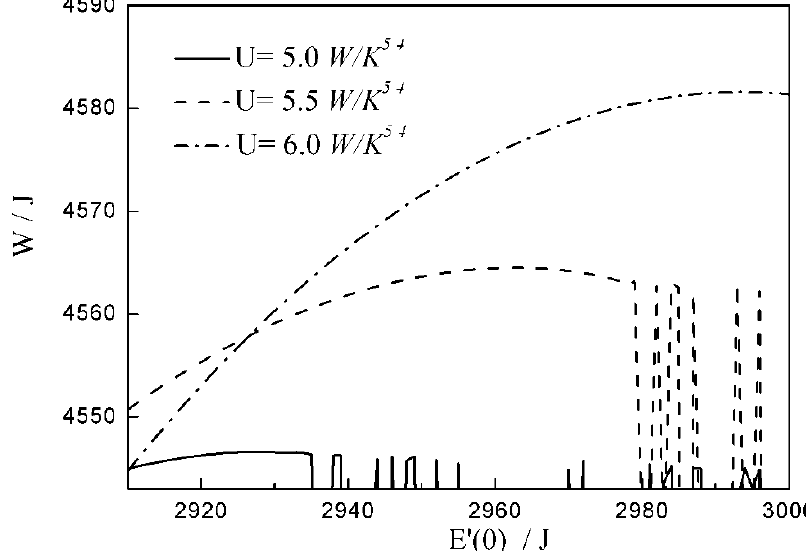
( ) E' 0 with variable heat conductance U as